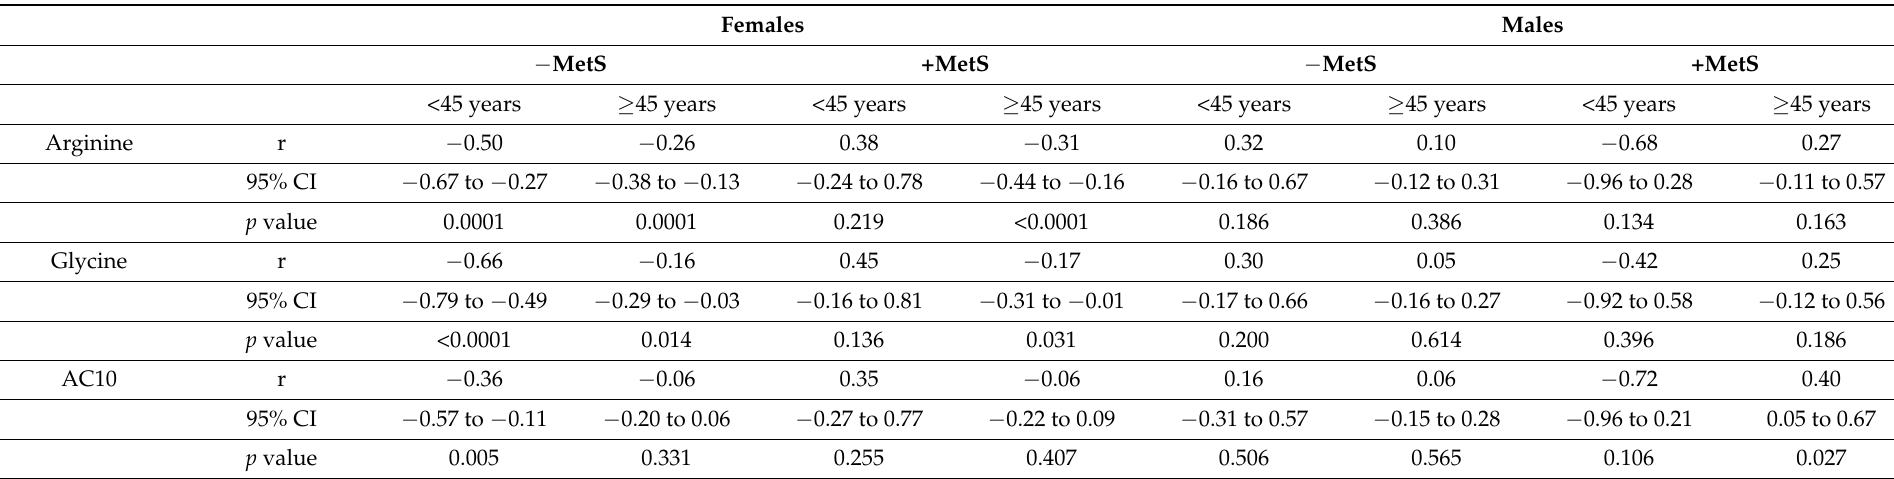
Table 3. Pearson correlation between body fat mass and metabolites associated with